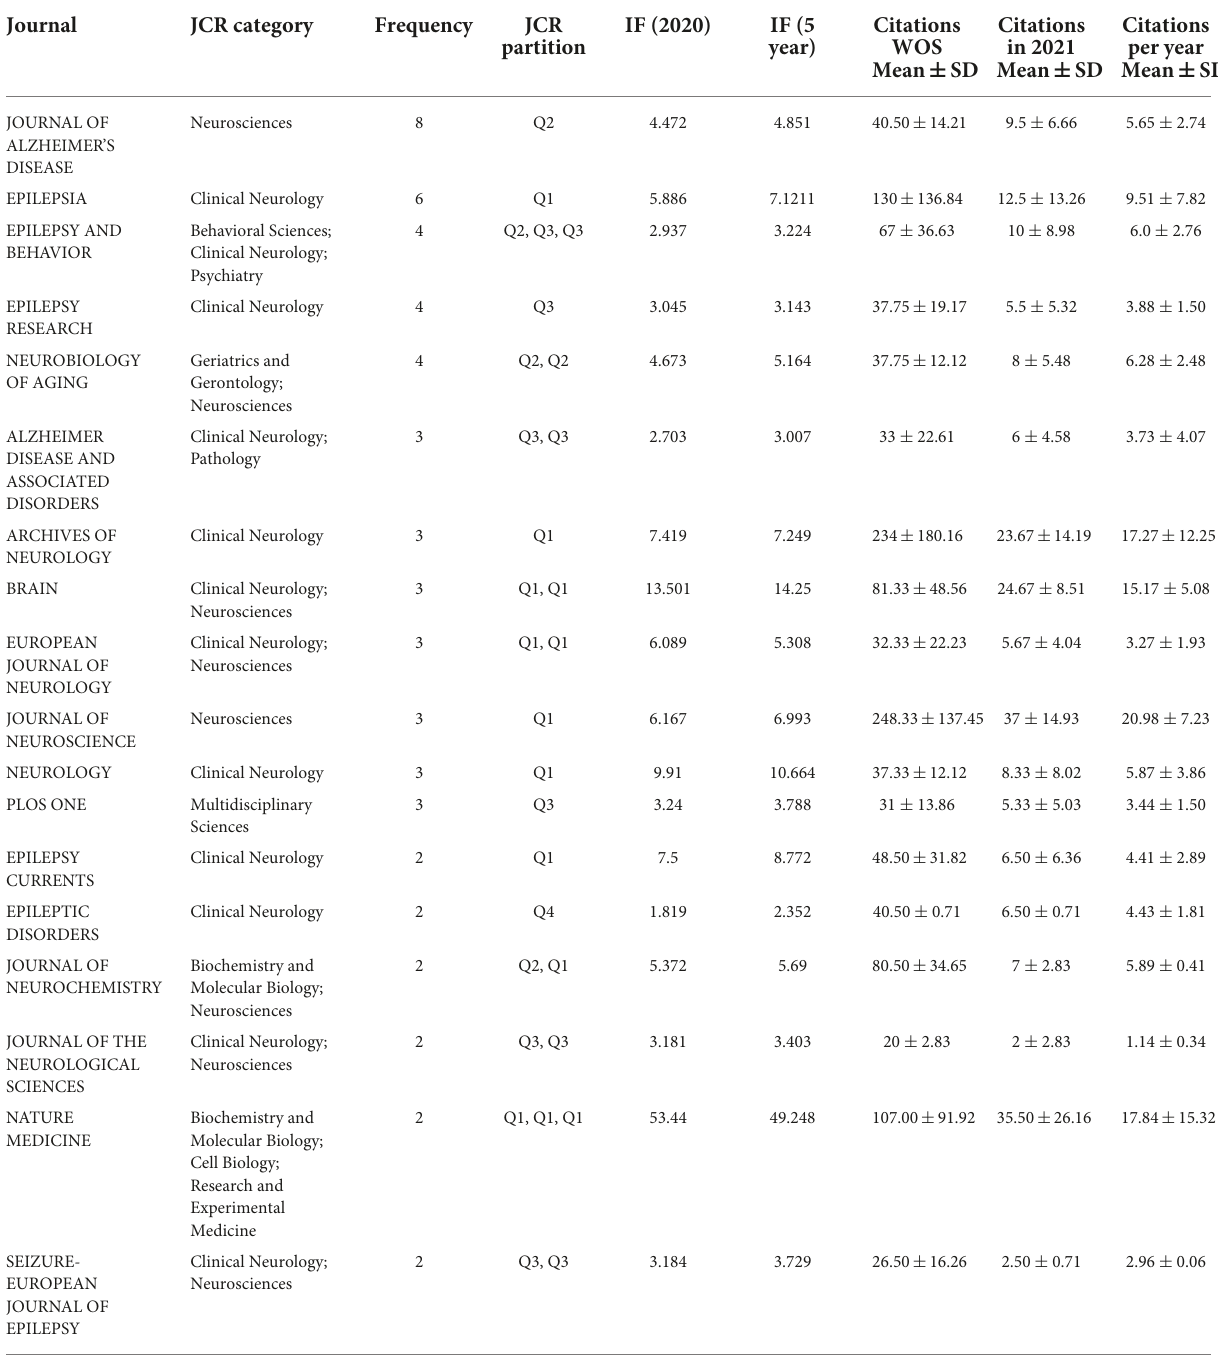
TABLE 3 Journals contributed ≥ 2 papers in the top 100 most-cited